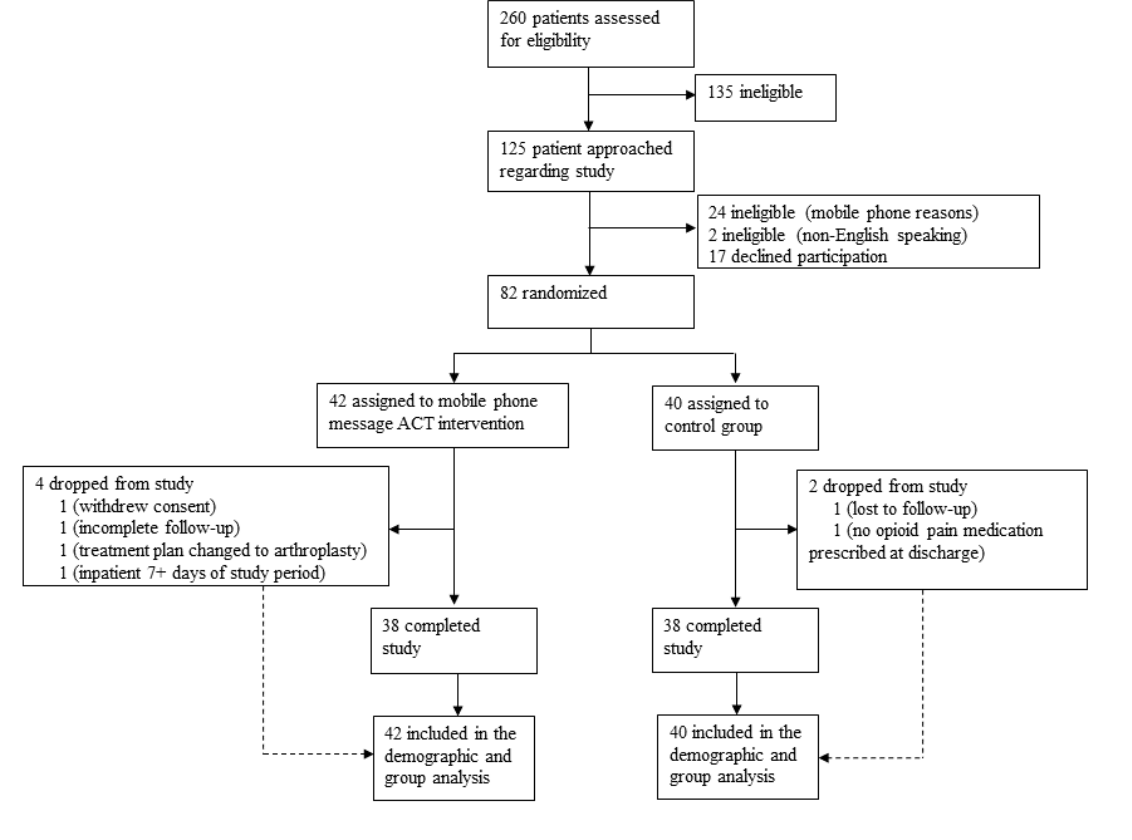
Figure 1. Consolidated Standards of Reporting Trials flowchart detailing the selection of eligible patients for study enrollment and their status through study completion. ACT: acceptance and commitment therapy.